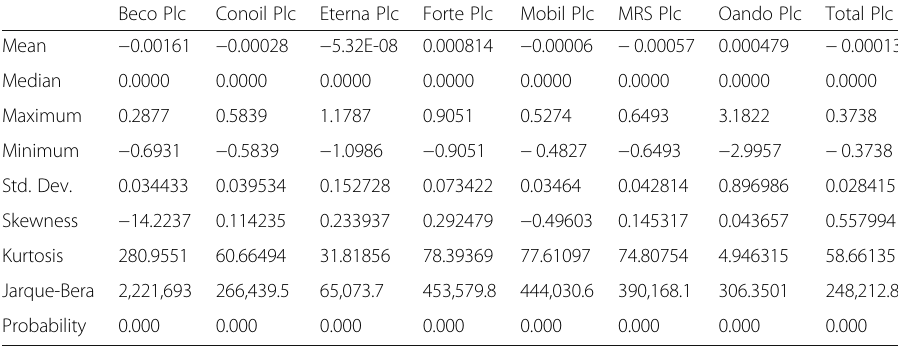
Table 1 Descriptive statistics of oil and gas company stock returns